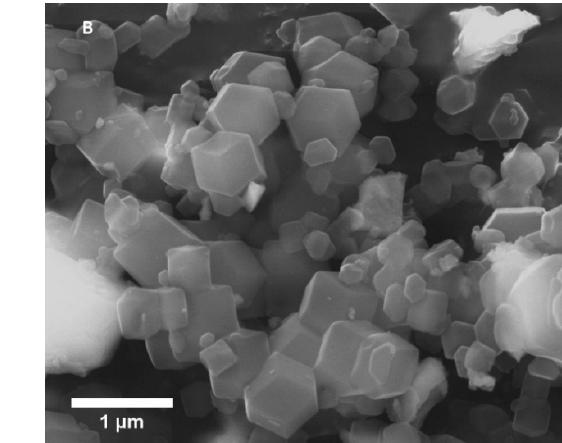
besides the Zn and N elements from the ZIF-8 support, the presence of W which further confirms the successful immobilization of EuW 10 in the composite material. Figure 2. Powder XRD patterns of the isolated ZIF-8 support and the EuW 10 @ZIF-8 composite.